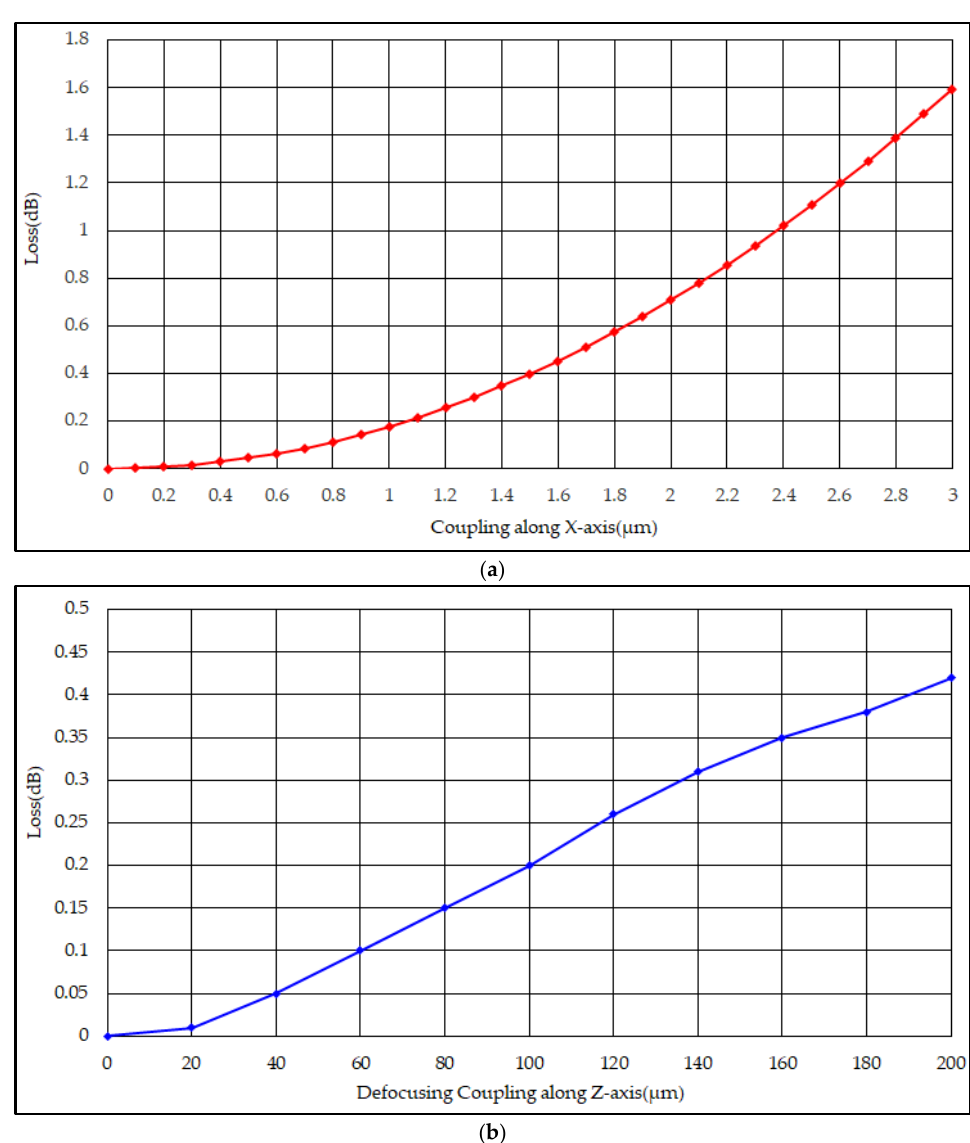
Figure 7. Changing of coupling efficiency along X-axis and defocusing coupling. ( a ) is the changing tendency curve of optical loss based on 2D coupling model. The horizontal axis is the distance the end-face moving from (0,0) along positive direction of X-axis, and the vertical axis is the power loss that the power at focal point minus the power at X-axis; ( b ) is the changing tendency curve of optical loss based on defocusing coupling along Z-axis. The horizontal axis is the distance the end-face moving from (0,0) along positive direction of Z-axis, and the vertical axis is the power loss that the power at focal point minus the power at Z-axis .